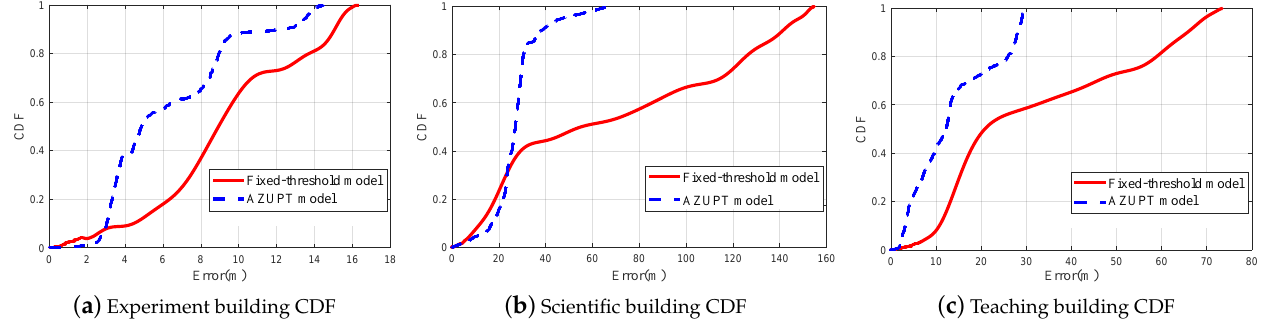
Figure 13. The CDF of the location errors with the fixed threshold model and the AZUPT model at different sites. Note that there were few false alarm points in walking for our AZUPT model to correct; therefore, our AZUPT method only showed relatively slight improvements compared to the fixed threshold method in Figure